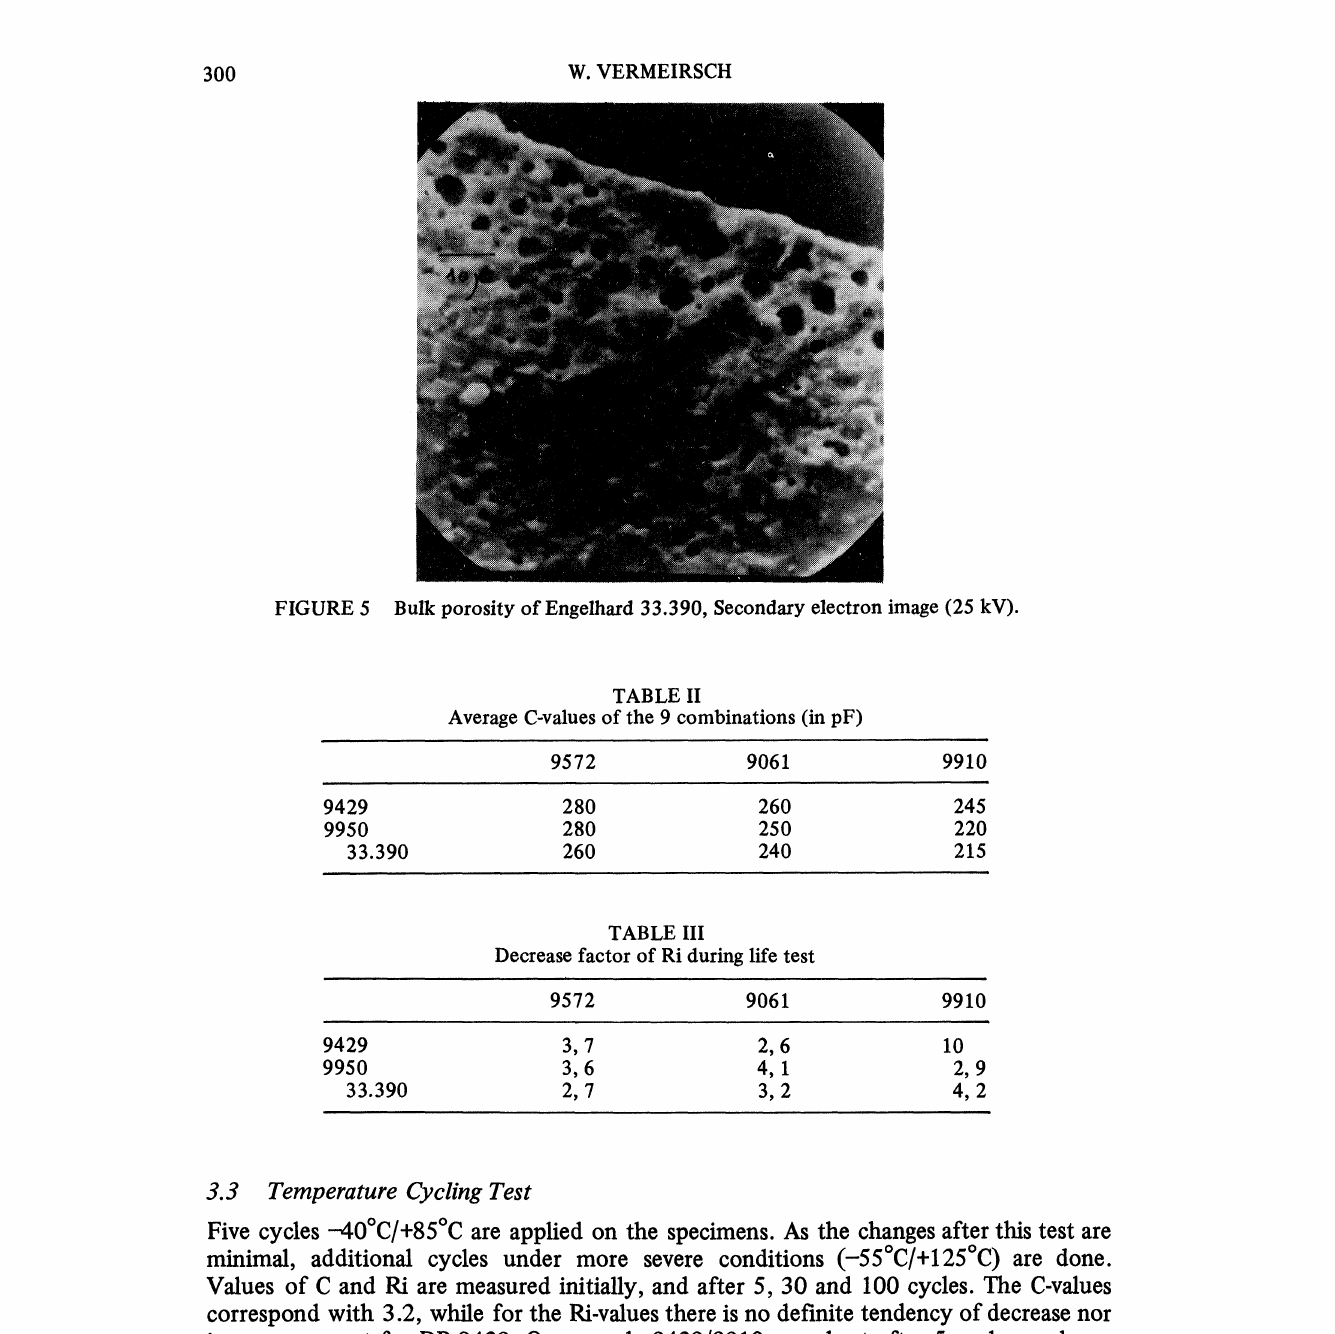
FIGURE 5 Bulk porosity of Engelhard 33.390, Secondary electron image (25 kV).